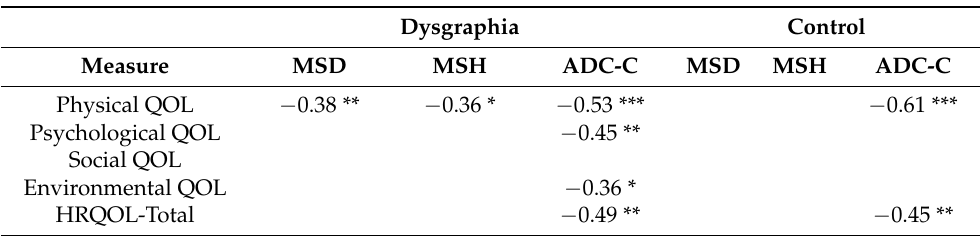
Table 6. Correlations between motor coordination, handwriting measures, and health-related quality of life (HRQOL).